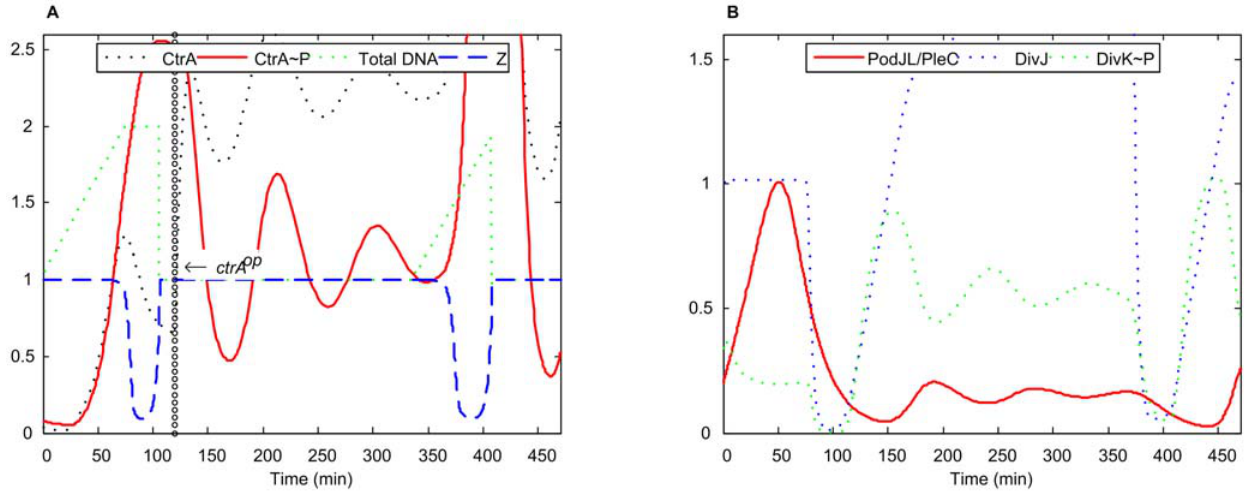
Figure 10. Simulation of D divJ mutant. k s,DivJ1 = k s,DivJ2 =0.